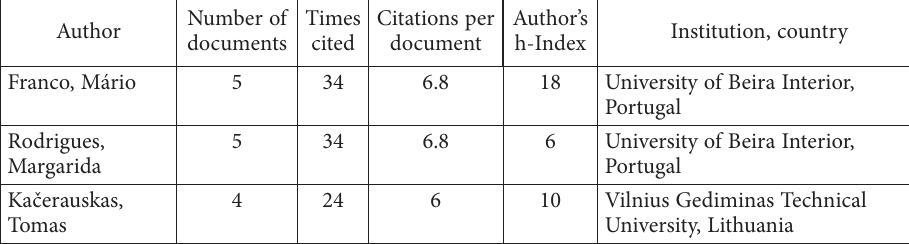
Table 2. Fifteen the most productive authors in the field (source: created by the authors)